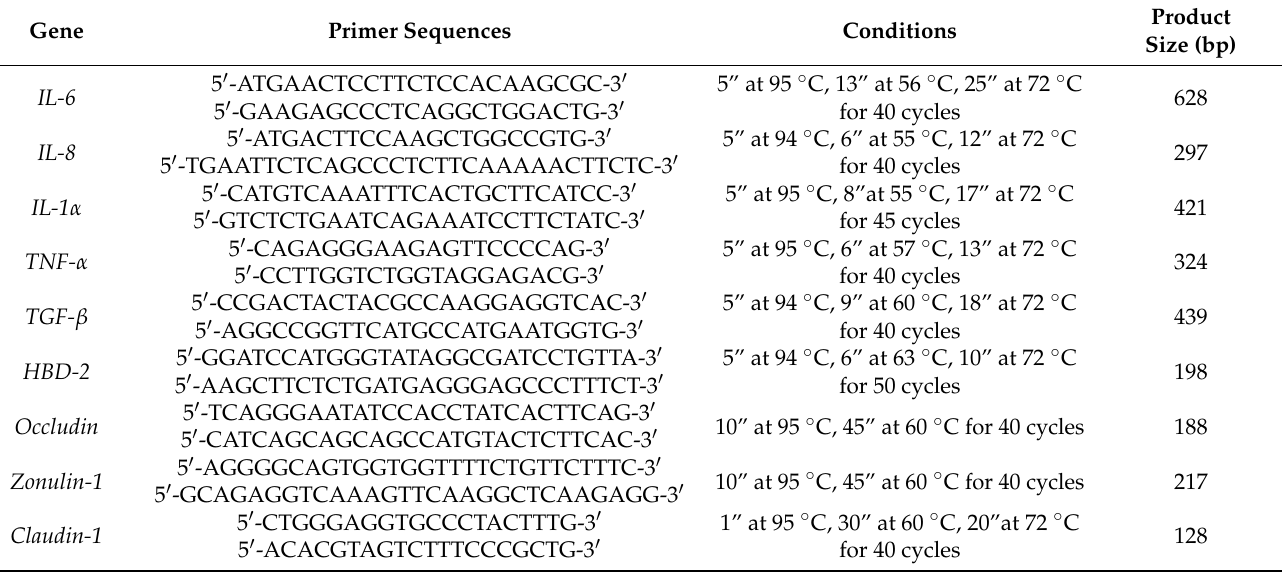
Table 1. Primer sequences and amplification